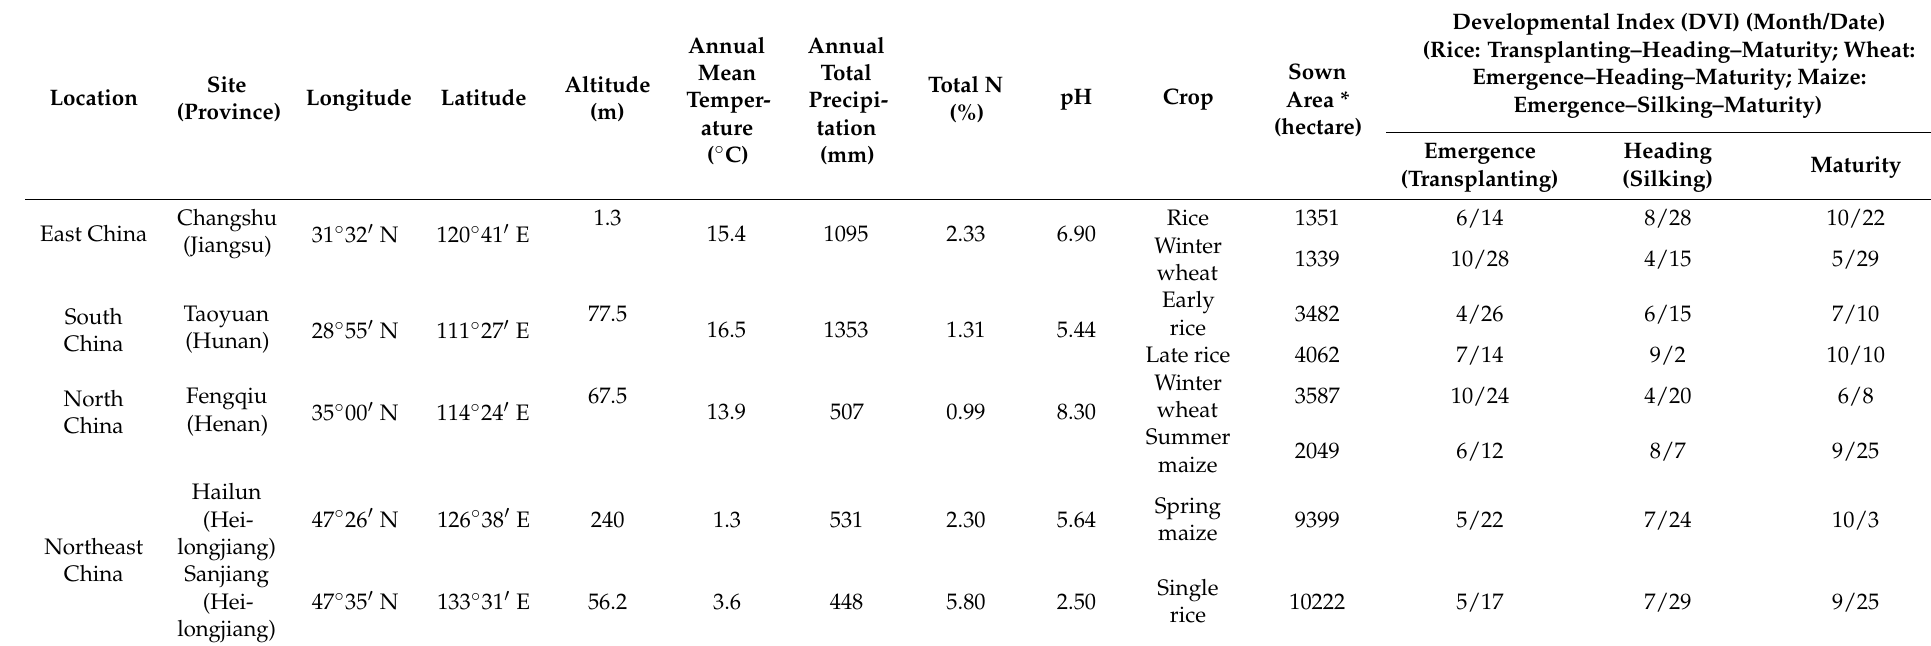
Table 1. Detailed information of the studied regions in Chinese Ecosystem Research Network